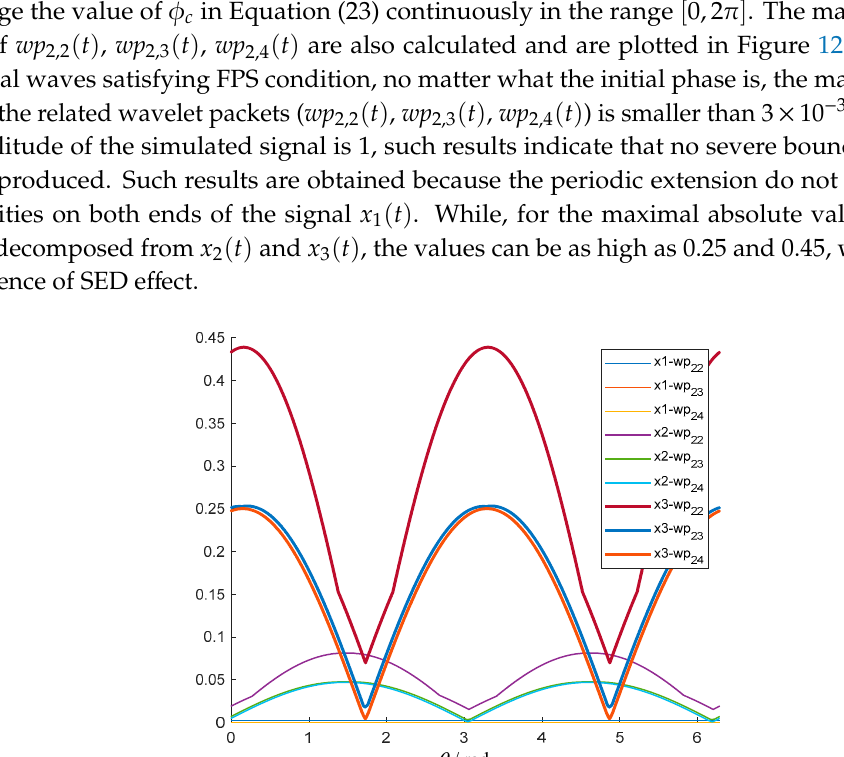
( ) wp t , ( ) wp t , ( ) wp t ) of the three 2,2 2,3 2,4